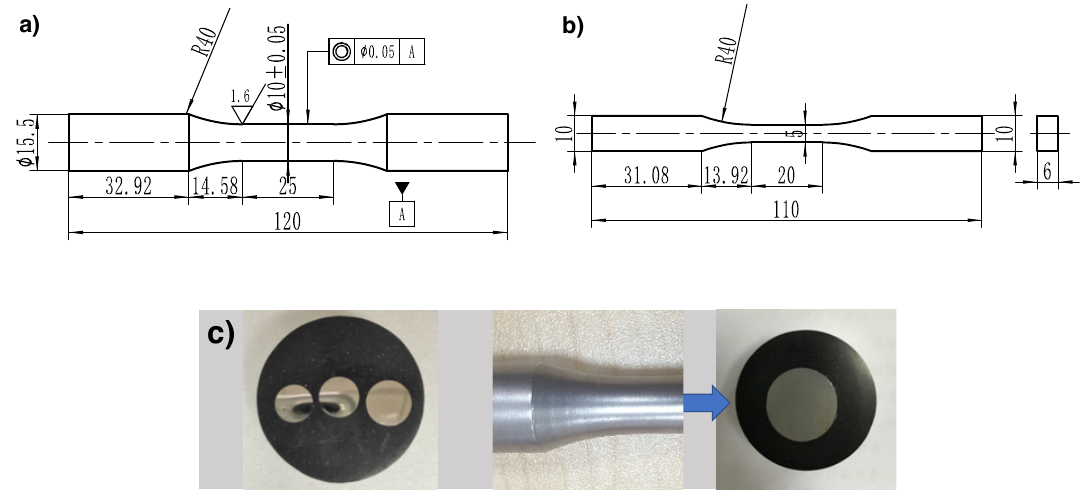
Figure 1. Specimen geometries tested in the present work. ( a ) The round specimens for instrumented indentation tests of the shot peening treatment. ( b ) The brick specimens for monotonic tensile tests of the pre-deformed treatment. ( c ) The samples for instrumented indentation tests of the pre-deformed and shot peening